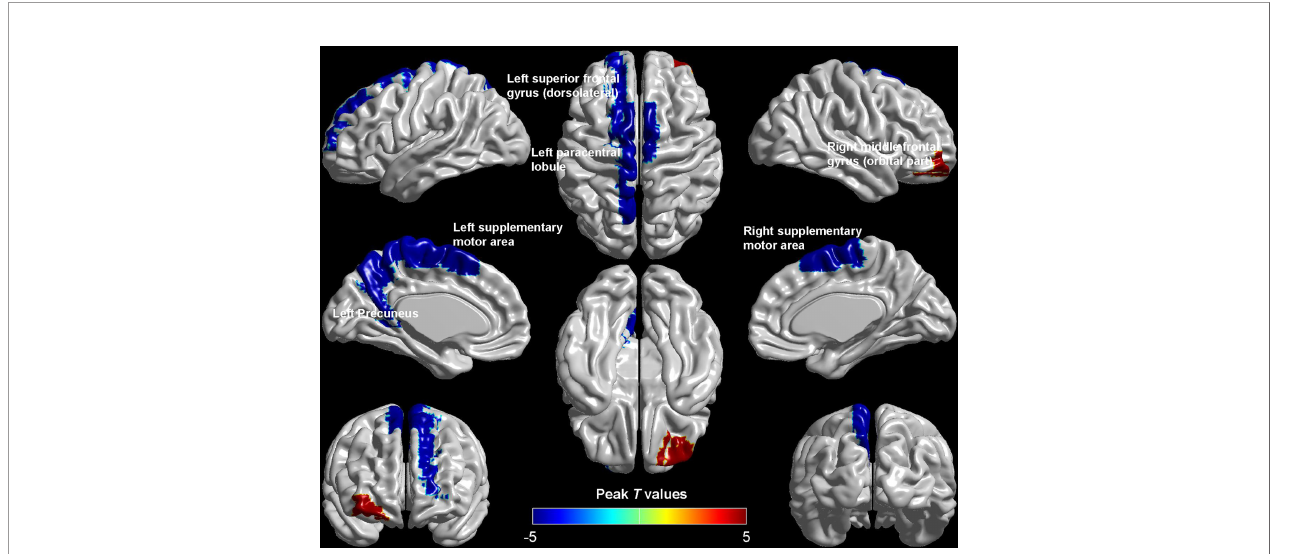
FIGURE 1 | Brain regions showed differences in ReHo values between DM-ED and HC